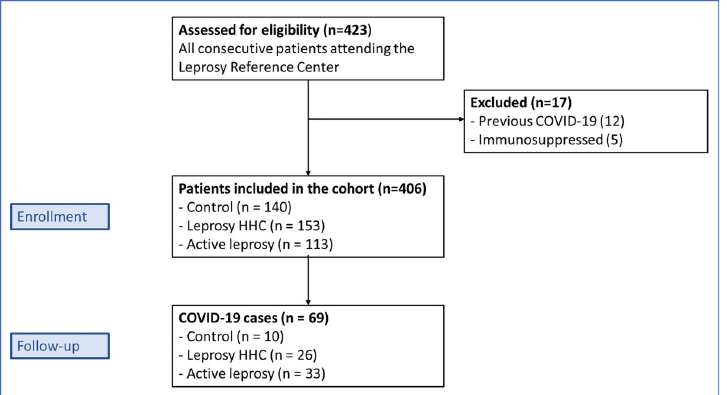
Fig 1. Study flow chart. HHC = household